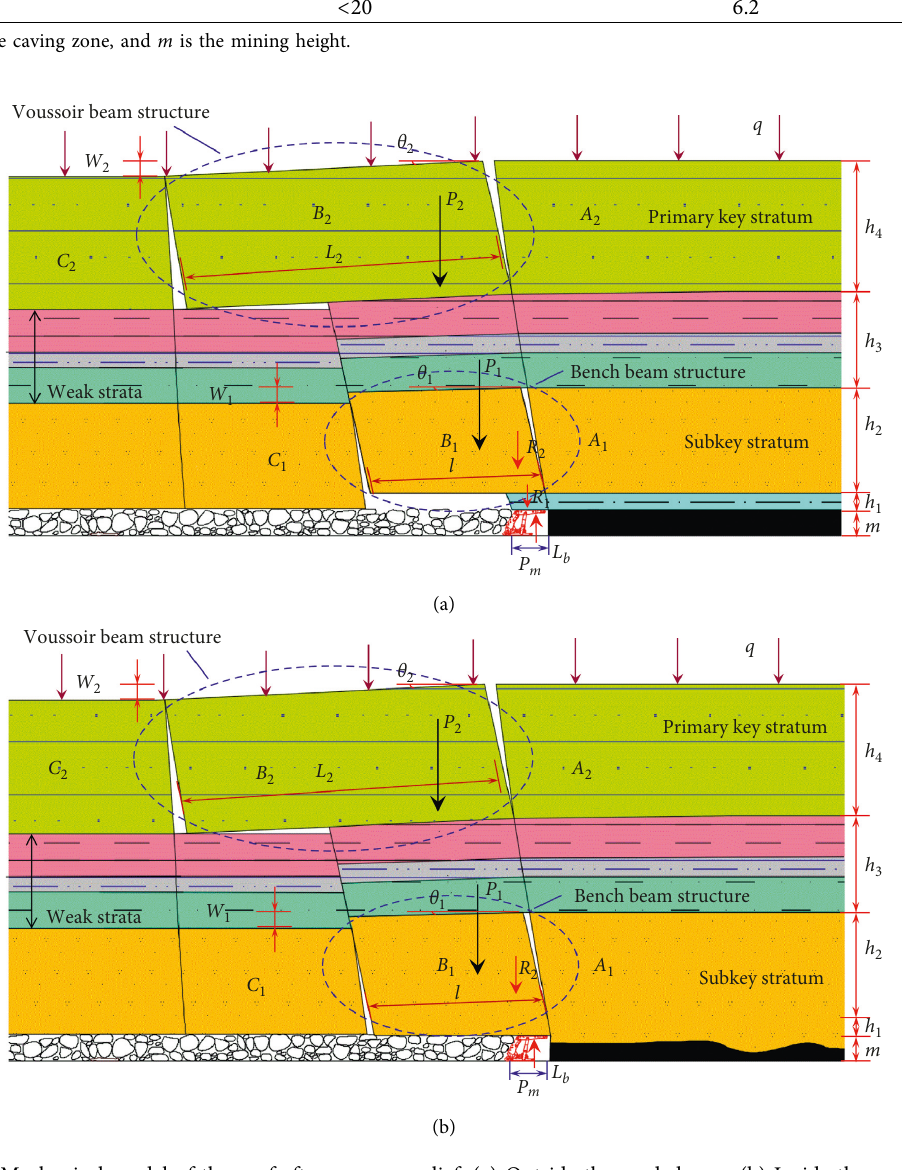
Figure 6: Mechanical model of the roof after pressure relief. (a) Outside the eroded area. (b) Inside the eroded area.